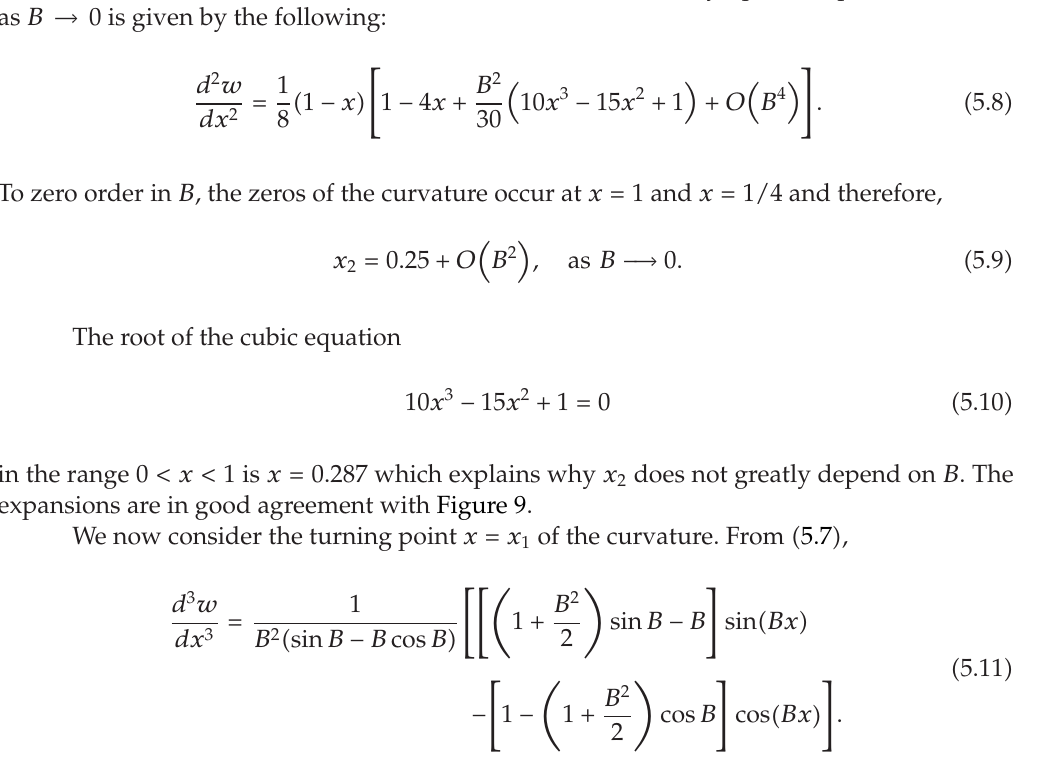
Graphs of the magnitude of the curvature for a range of values B < B 1 are given in Figure